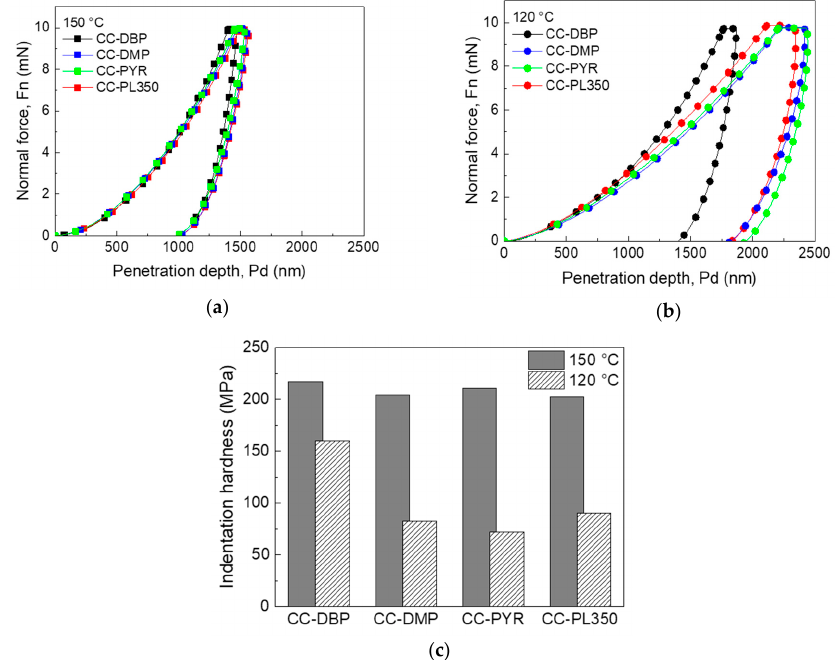
Figure 5. Indentation curves of clearcoat films having pyrazole-based BIs cured at ( a ) 150 ◦ C and